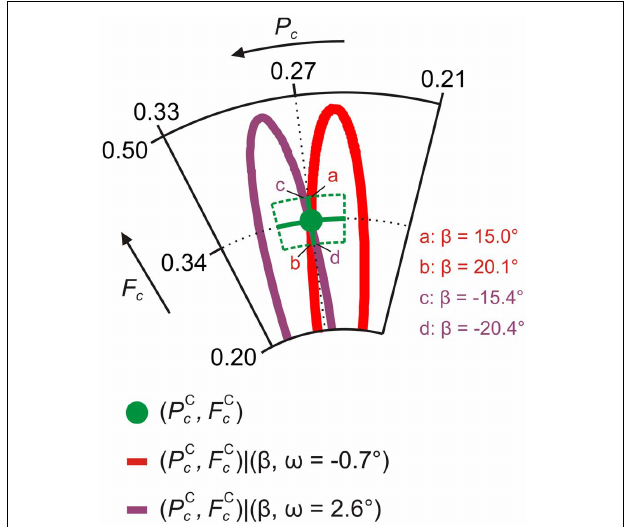
FIGURE 10 | Comparison of NIXSW simulations and experimental data for AB/Ag(111). Argand diagram of the NIXSW experimental results (green dot, Figure 6 ) and of NIXSW simulations of carbon average structure parameters ( P C c , F C c ) for: ω = − 0 . 7 ◦ and − 26 . 7 ◦ ≤ β ≤ 26 . 5 ◦ (red line); ω = 2 . 6 ◦ and − 26 . 6 ◦ ≤ β ≤ 27 . 1 ◦ (purple line). For all NIXSW